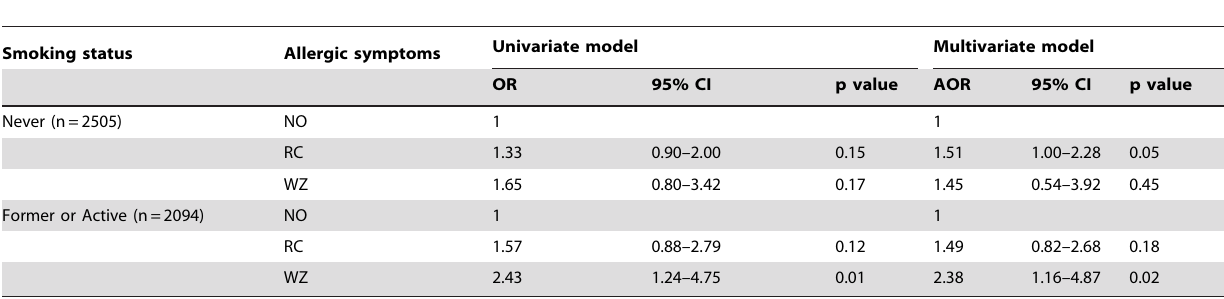
Table 3. Association between allergic symptoms and cancer among smokers and nonsmokers.